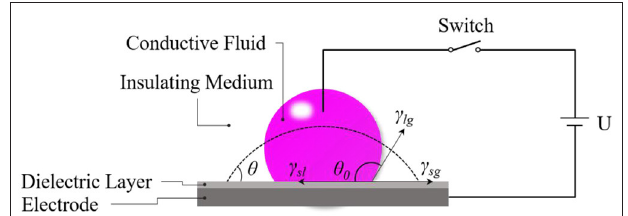
FIGURE 1 | Schematic diagram of an EWOD. When no external voltage was applied, the conductive fluid was in a contracted state, as shown in the red part. When an appropriate driving voltage was applied, the contracted conductive droplet can be spread out, as shown by the dotted line.